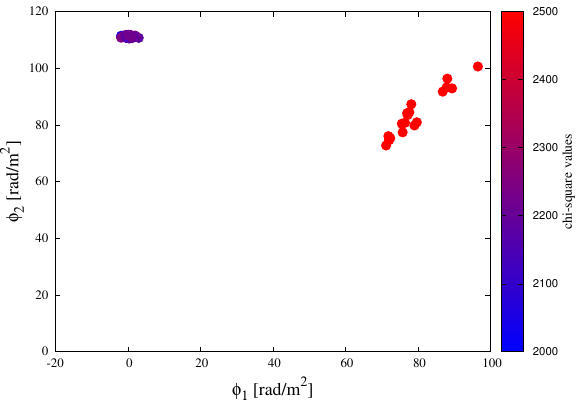
Figure 3. Correlation of the estimated best-fit Faraday depths of the w2g4 source model in 100 realizations. Color indicates the chi-square values calculated by Equation